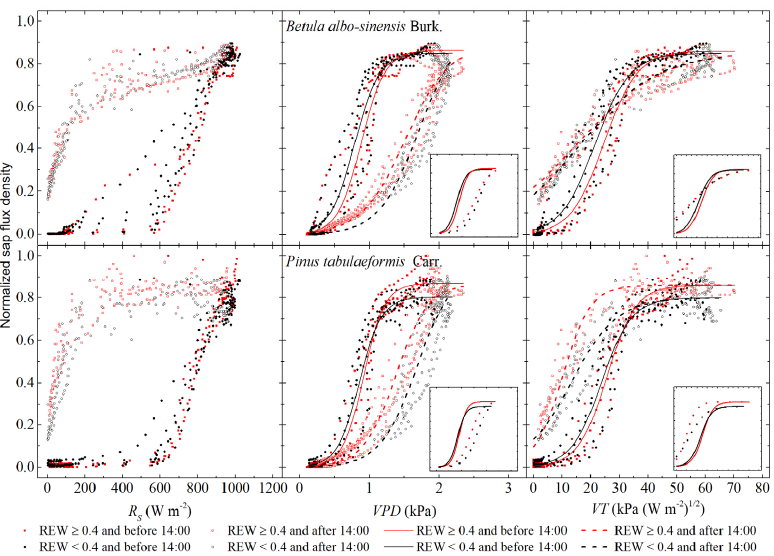
Figure 6. Normalized F d in relation to the R s , the VPD and the variable of transpiration ( VT ) in the daytime hours in August for each species under different soil ‐ water conditions and time. Note that the upper row is for B. albosinensis and the lower row is for P. tabuliformis. The black filled circles and the black solid line indicate the relationships with the REW <0.4 and before 14:00, respectively; the black open circles and the black dotted line indicate the REW <0.4 and after 14:00, respectively; the red filled squares and the red solid line indicate the REW <0.4 and before 14:00, respectively; and the red open squares and the red dotted line indicate the REW ≥ 0.4 and after 14:00, respectively. The DoseResp curves were well fitted to all the F d ‐ VPD and F d ‐ VT datasets (refer to Tables 2 and 3). Each dot represents the normalized sap flux density converted from the sap flux density averaged from all probes for each species.